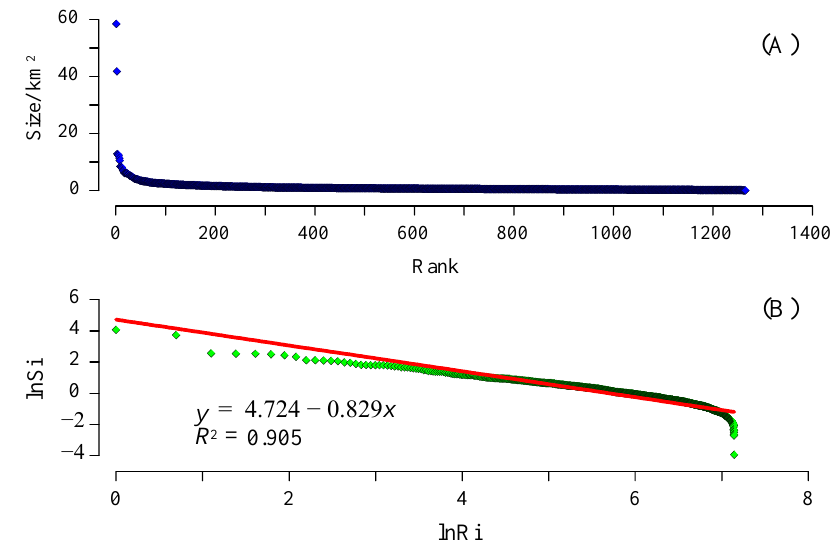
Figure 6. City rank-size curve ( A ) and double logarithmic scatter plot ( B ) of the rank-size distribution in the TCE.